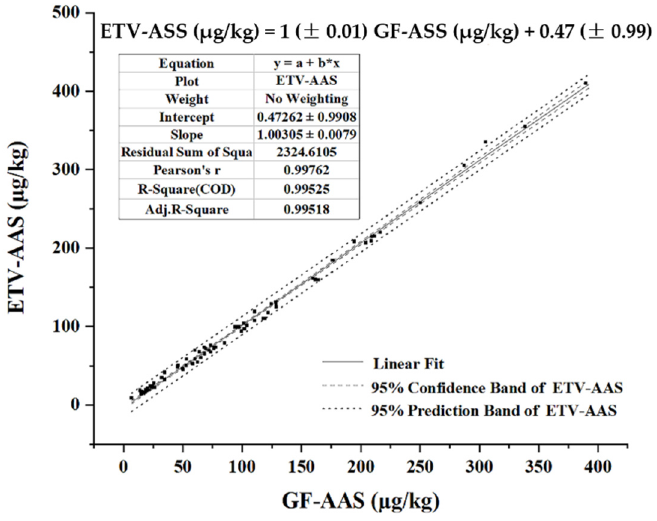
Figure 5. Comparison of Cd signal peaks between a real chocolate sample and standard solution. The Cd concentration of chocolate sample (No. 9) is 18.4 ± 2 ng/g; the Cd concentration of standard solution is 18 ng/mL.